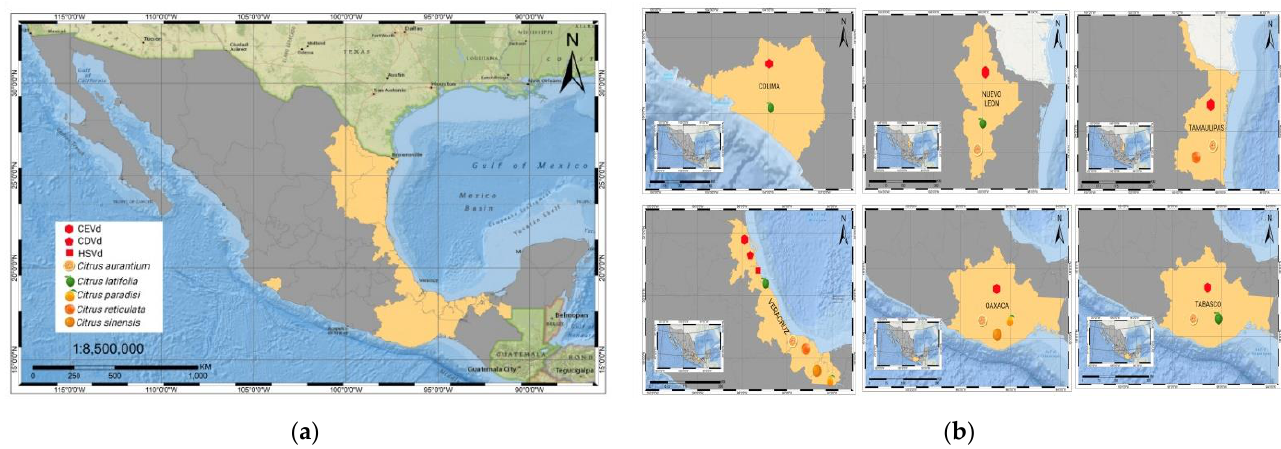
Figure 8. ( a ) Distribution of viroids in Mexico associated with citrus diseases. ( b ) Geographical areas and description of the affected citrus plantations by the different viroid species.